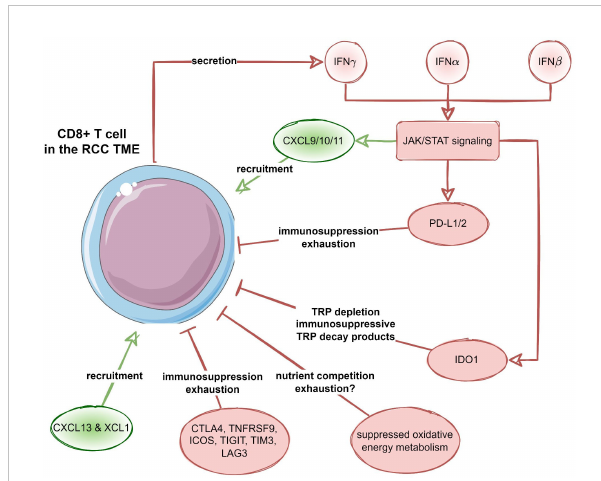
FIGURE 11 Recruitment and suppression of CD8 + T cells in the RCC microenvironment. Proposed negative feedback between the CXCL9/ 10/11-, CXCL13- and XCL1-mediated CD8 + T cell recruitment, interferon (IFN) - JAK/STAT signaling, as well as T cell suppression and exhaustion by immune checkpoint proteins, suppression of oxidative energy metabolism and tryptophan degradation to immunosuppressive metabolites by increased IDO1